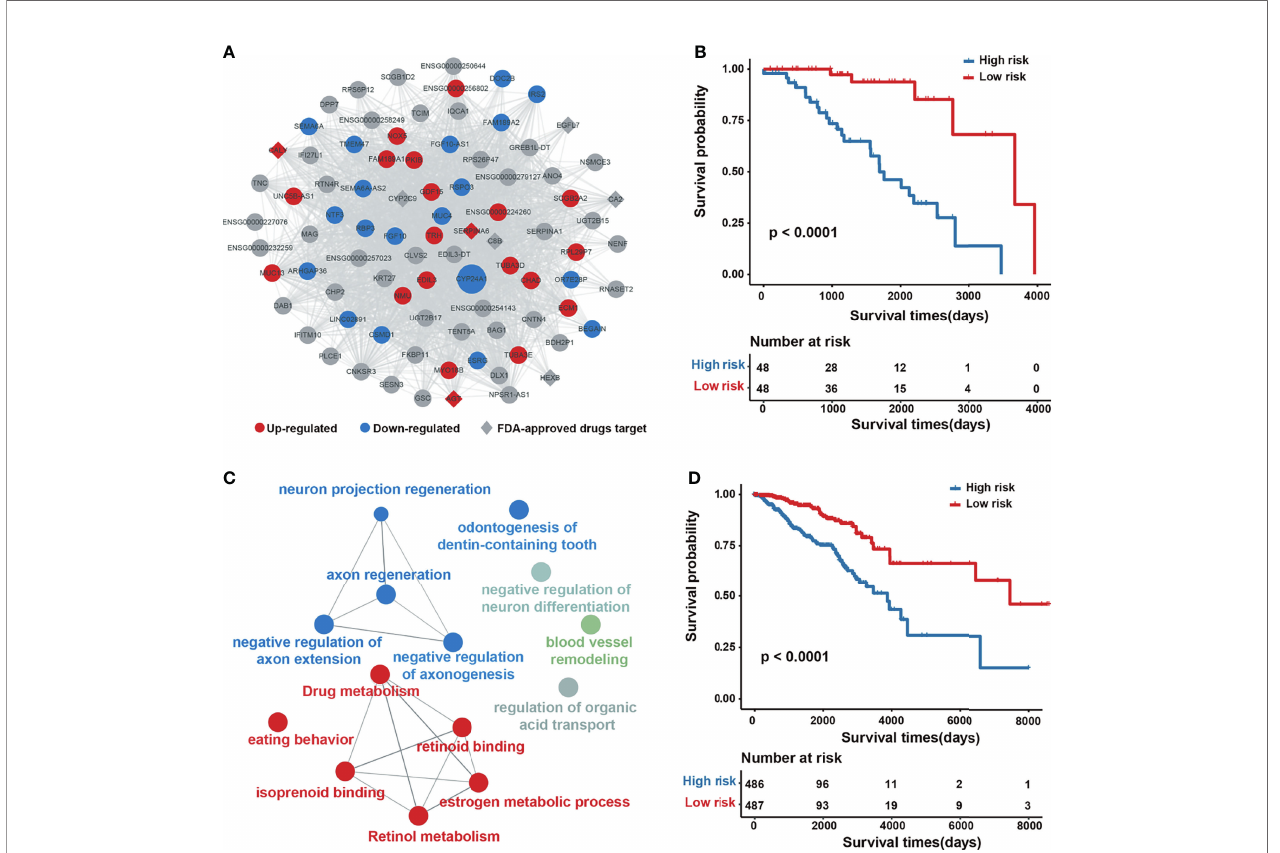
FIGURE 3 | Network architecture and prognostic analysis of the salmon2 module. (A) Network plot of the salmon2 module. The upregulated, downregulated, and non – differentially expressed genes are colored with red, blue, and gray, respectively. The rhombus represents the drug target. The size of a node represents the degree of connectivity in the network. (B) Kaplan – Meier analysis for 96 patients with high-risk or low-risk scores. P -values were calculated using the two-sided log- rank test. (C) Gene ontology enrichment analysis of the genes in the salmon2 module. (D) Kaplan – Meier analysis for 974 independent veri fi cation